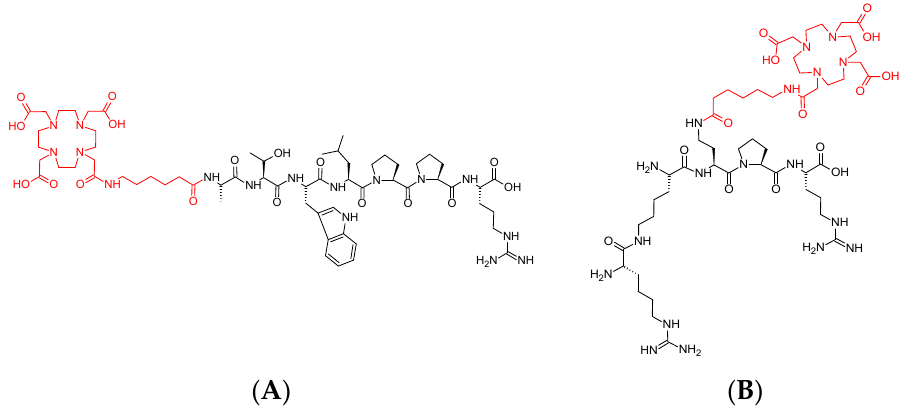
Figure 1. Chemical structure of molecules: ( A ) DOTA-Ahx-A7R (conjugate 1 ); ( B ) Lys(hArg)- Dab(Ahx-DOTA)-Pro-Arg (conjugate 2 ). The DOTA chelator and Ahx linker that were attached to the parent compounds (in black) are shown in red.